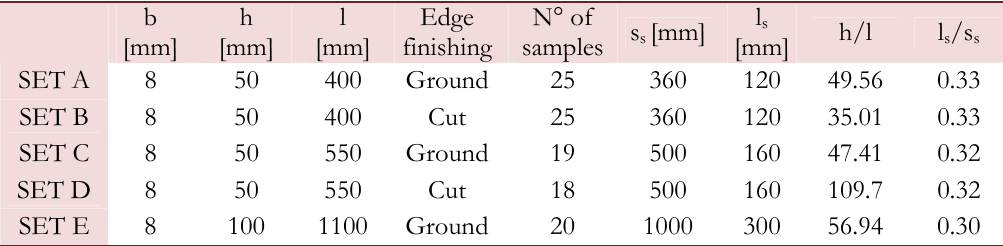
Table 2: Geometrical dimensions, edge finishing and number of the samples for the various sets of glass